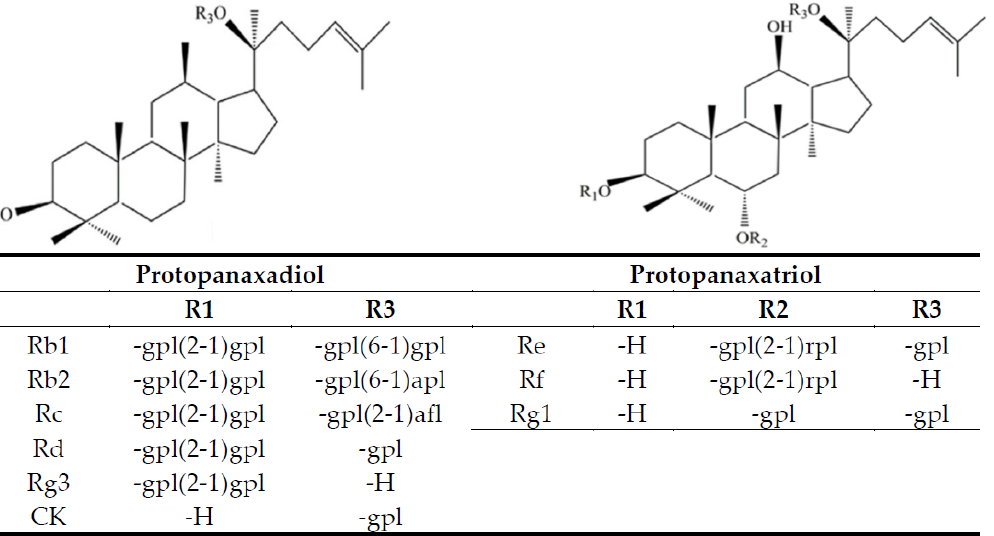
Figure 1. Chemical structures of 9 ginsenosides analyzed in this study. gpl, β -D-glucopyranosyl; apl, α -L-arabinopyranosyl; afl, α -L-arabinofuranosyl; rpl, α -L-rhamnopyranosyl; H, hydrogen.